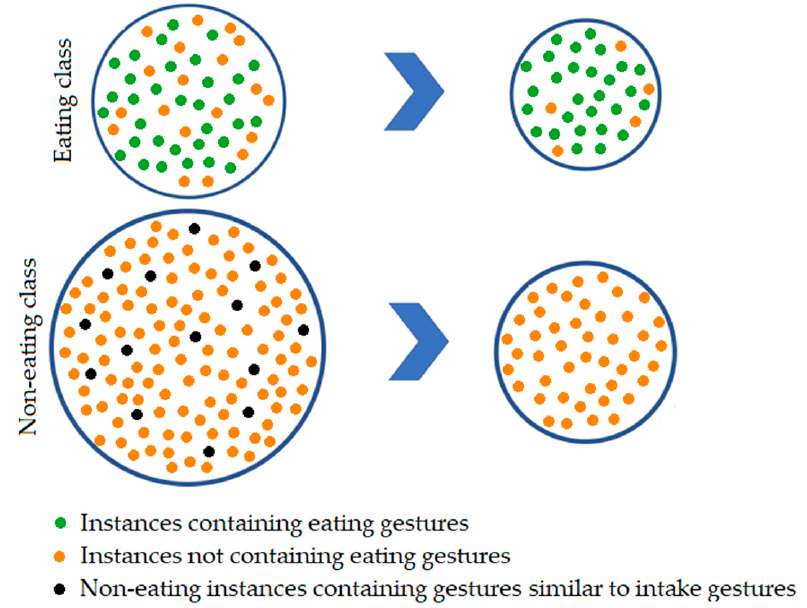
Figure 7. Composition of the eating and non-eating classes before and after all steps of the data selection procedure.